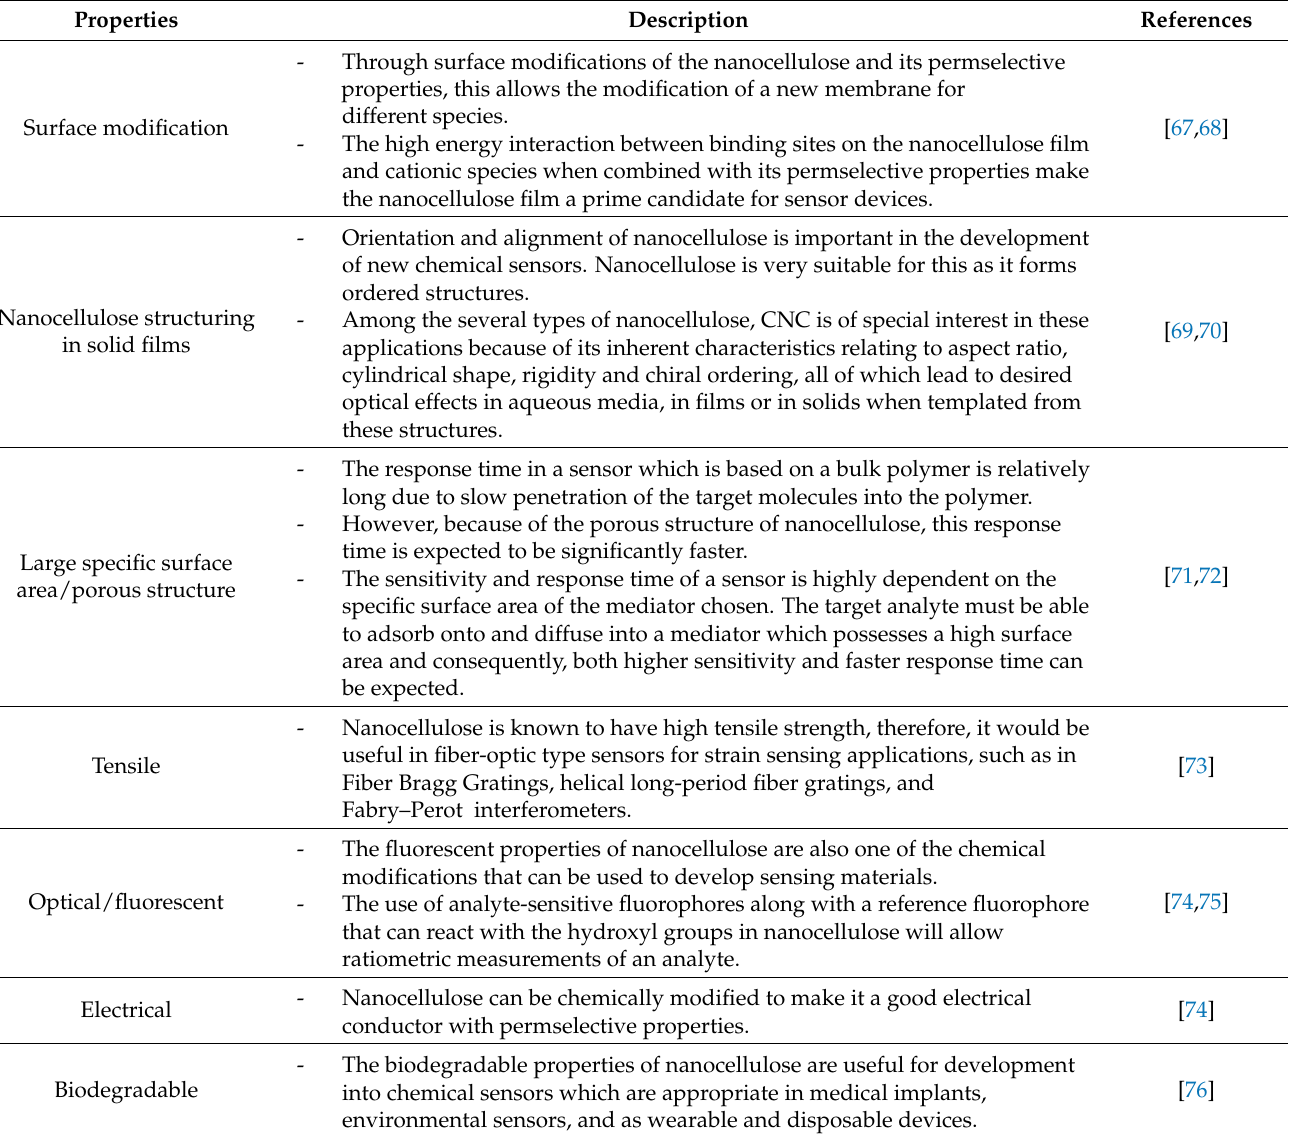
Table 1. Merits of nanocellulose as chemical